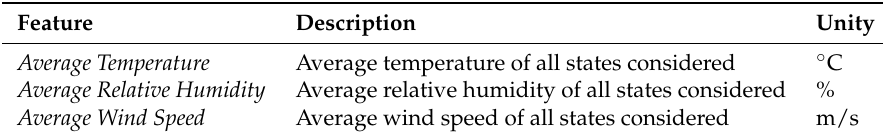
Table 3. Additional set of collected data (other